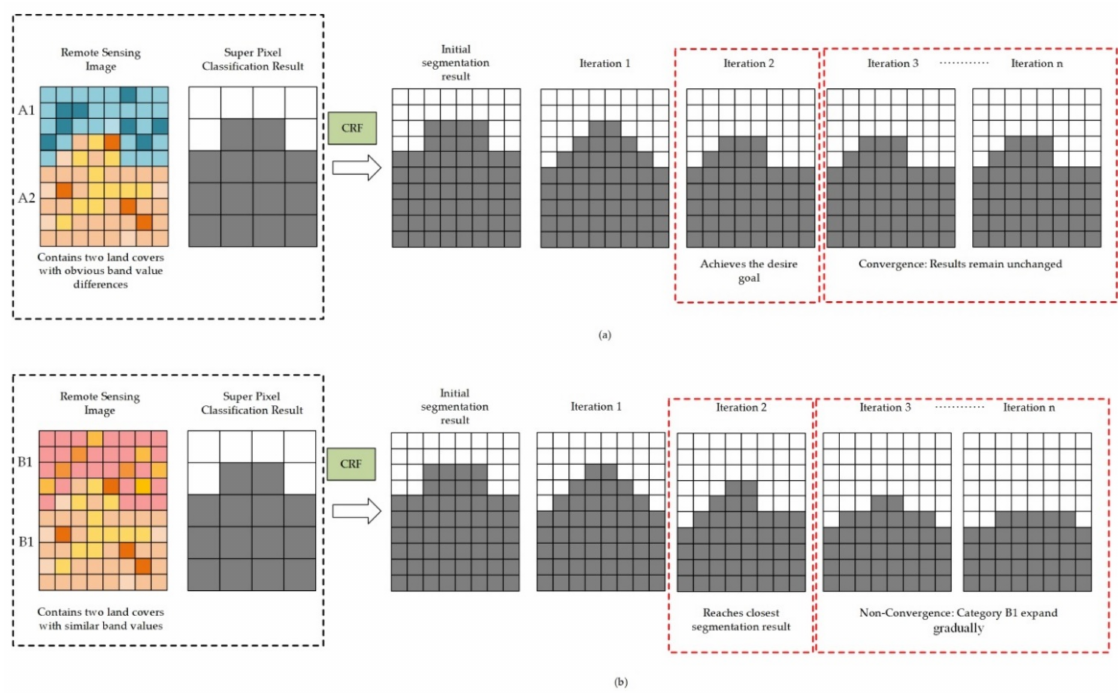
Figure 1. Process of obtaining pixel-based segmentation result via conditional random fields (CRF). ( a ) The results of CRF under ideal conditions; ( b ) The results of CRF under real